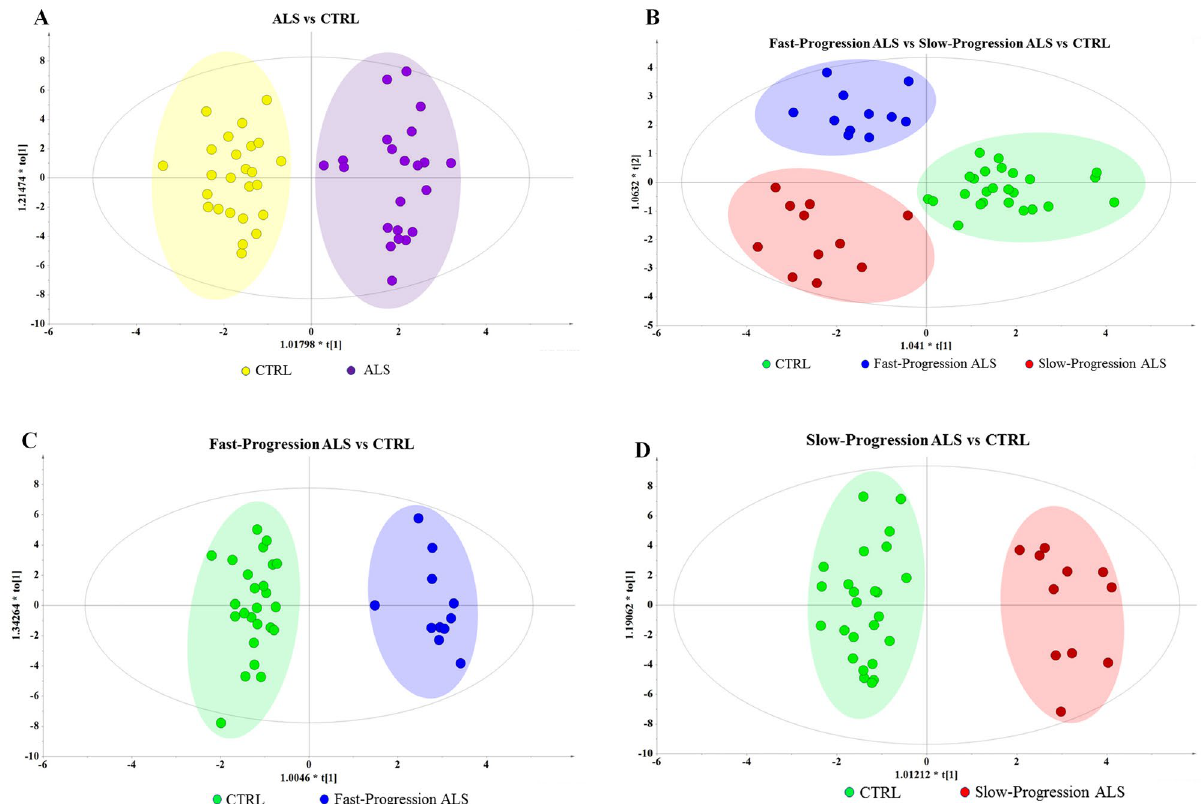
Figure 1. OPLS-DA score plots of ALS patients versus healthy subjects. OPLS-DA analysis shows a clear separation in ( A ) ALS versus CTRL, ( B ) fast-progression ALS versus slow-progression ALS versus CTRL, ( C ) fast-progression ALS versus CTRL, and ( D ) slow-progression ALS versus